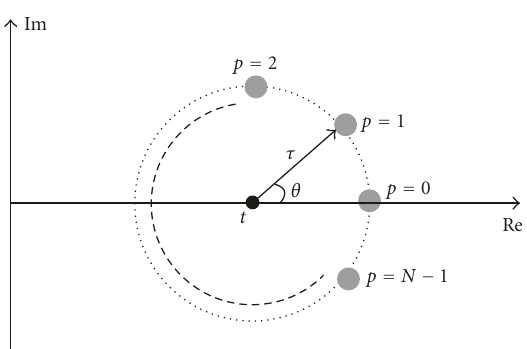
Figure 3: The complex lag